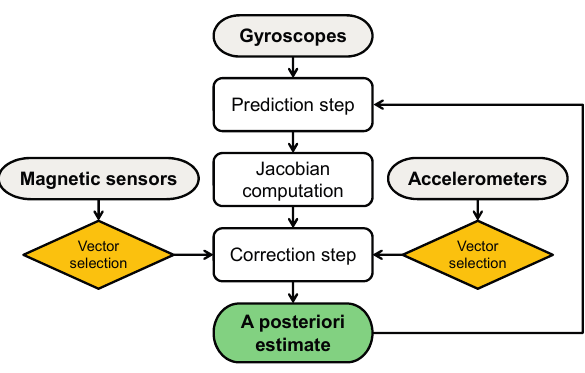
Figure 2. Framework of the SF method.